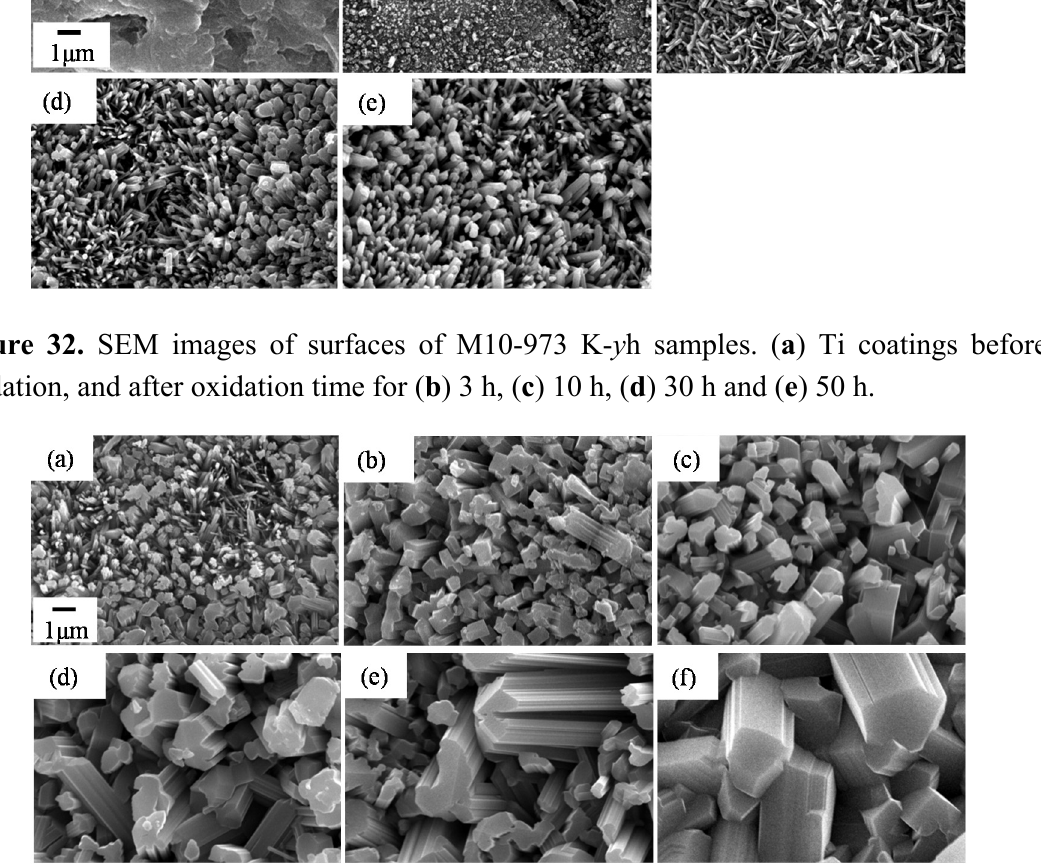
Figure 33. SEM images of surfaces of M10-1073 K- y h samples. ( a ) 3 h, ( b ) 10 h, ( c ) 20 h, ( d ) 30 h, ( e ) 40 h and ( f ) 50